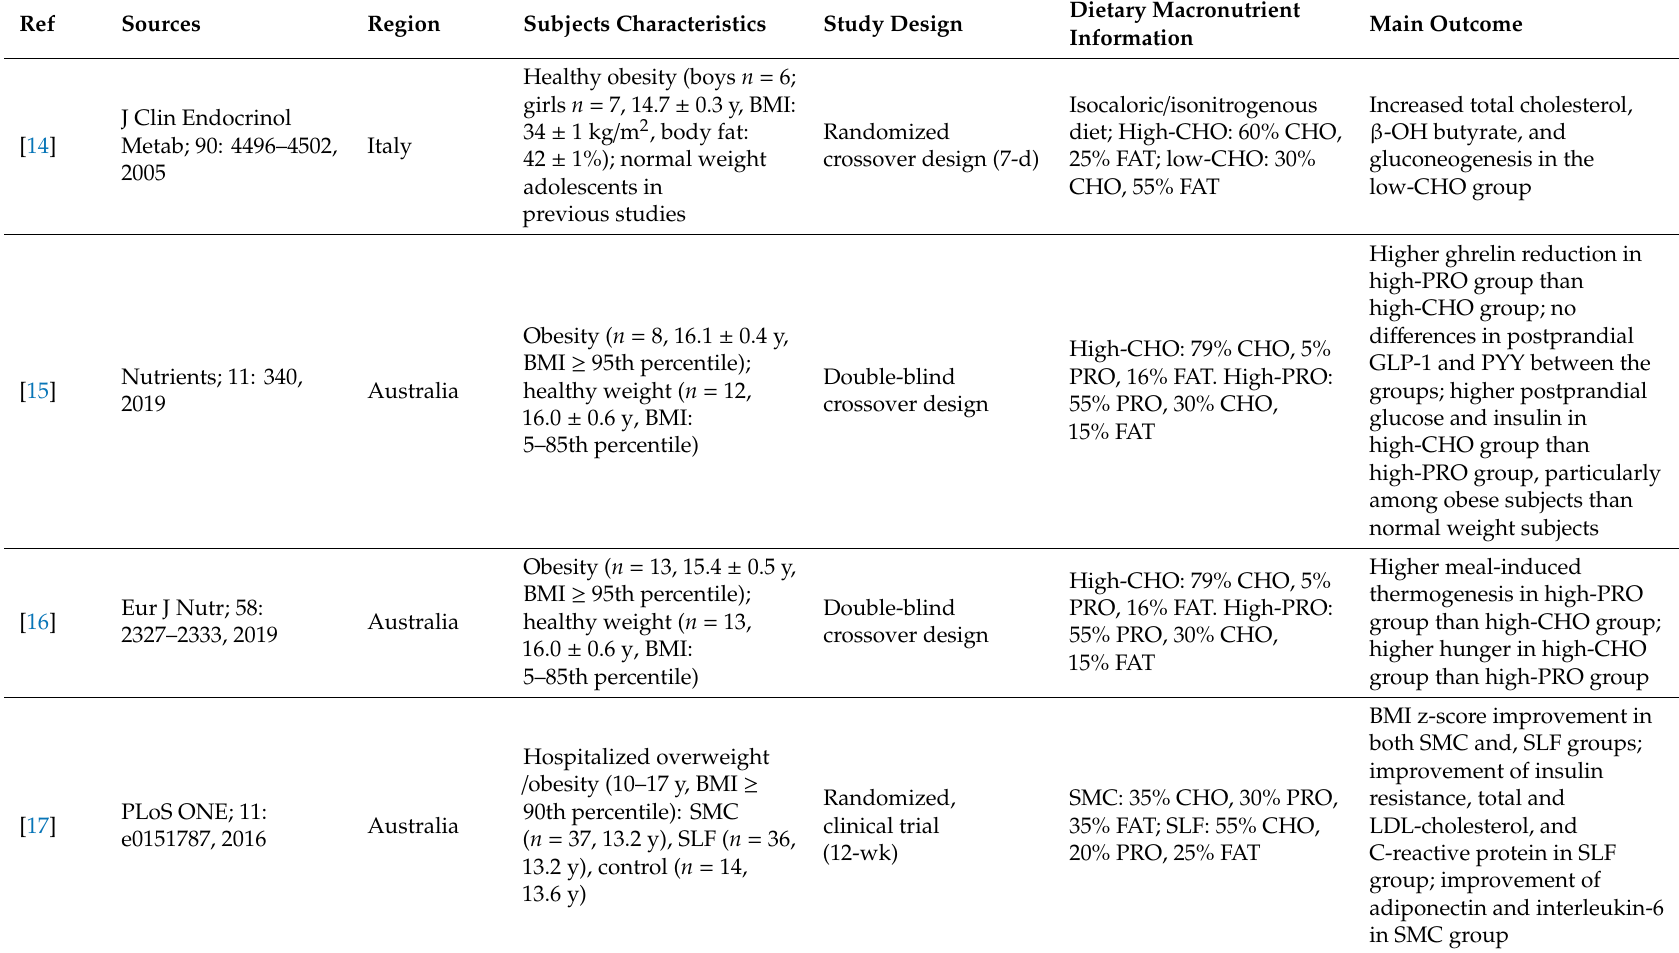
Table 1. Descriptive information for the selected studies on the macronutrient e ff ects on body composition and metabolic improvement in obese children and